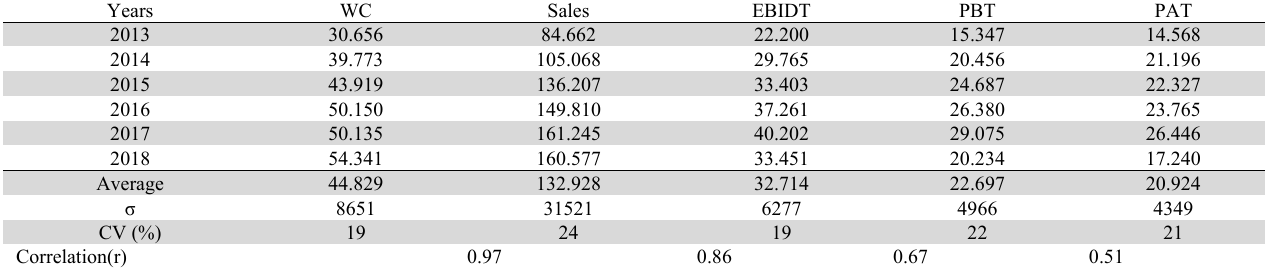
Variability and correlation between average working capital and sales, EBIT, PBT, and PAT (amounts in Million Rs.) of selected leading pharmaceuticals companies of India